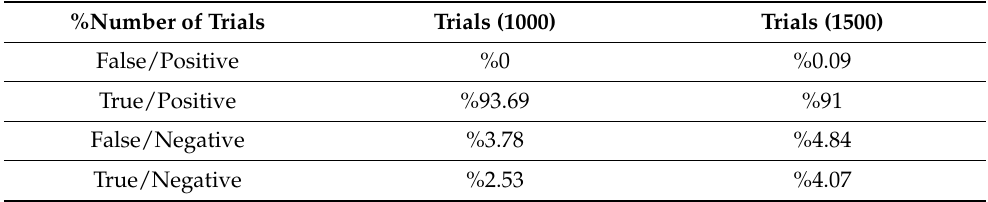
Table 3. Comparison among different